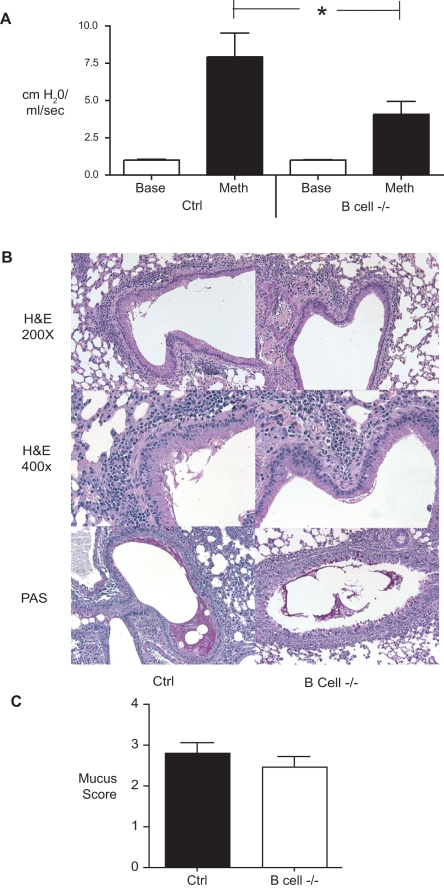
Lung pathophysiology in control and B cell −/− mice.(A) Airway hyperreactivity in control and B cell −/− mice. AHR was assessed by whole body plethysmography. The Y-axis corresponds to the increase in airway resistance observed following methacholine challenge. Bars represent the mean of 8–9 mice per group ±SEM. * = p<0.05 (B) Representative histology of lung sections from control allergen challenged and B cell−/− mice. H&E: Hemotoxylin and eosin, PAS: periodic acid Schiff's stain. (C) Histological scoring of PAS-stained lung sections. Bars represent the mean of 5 mice per group ±SEM.